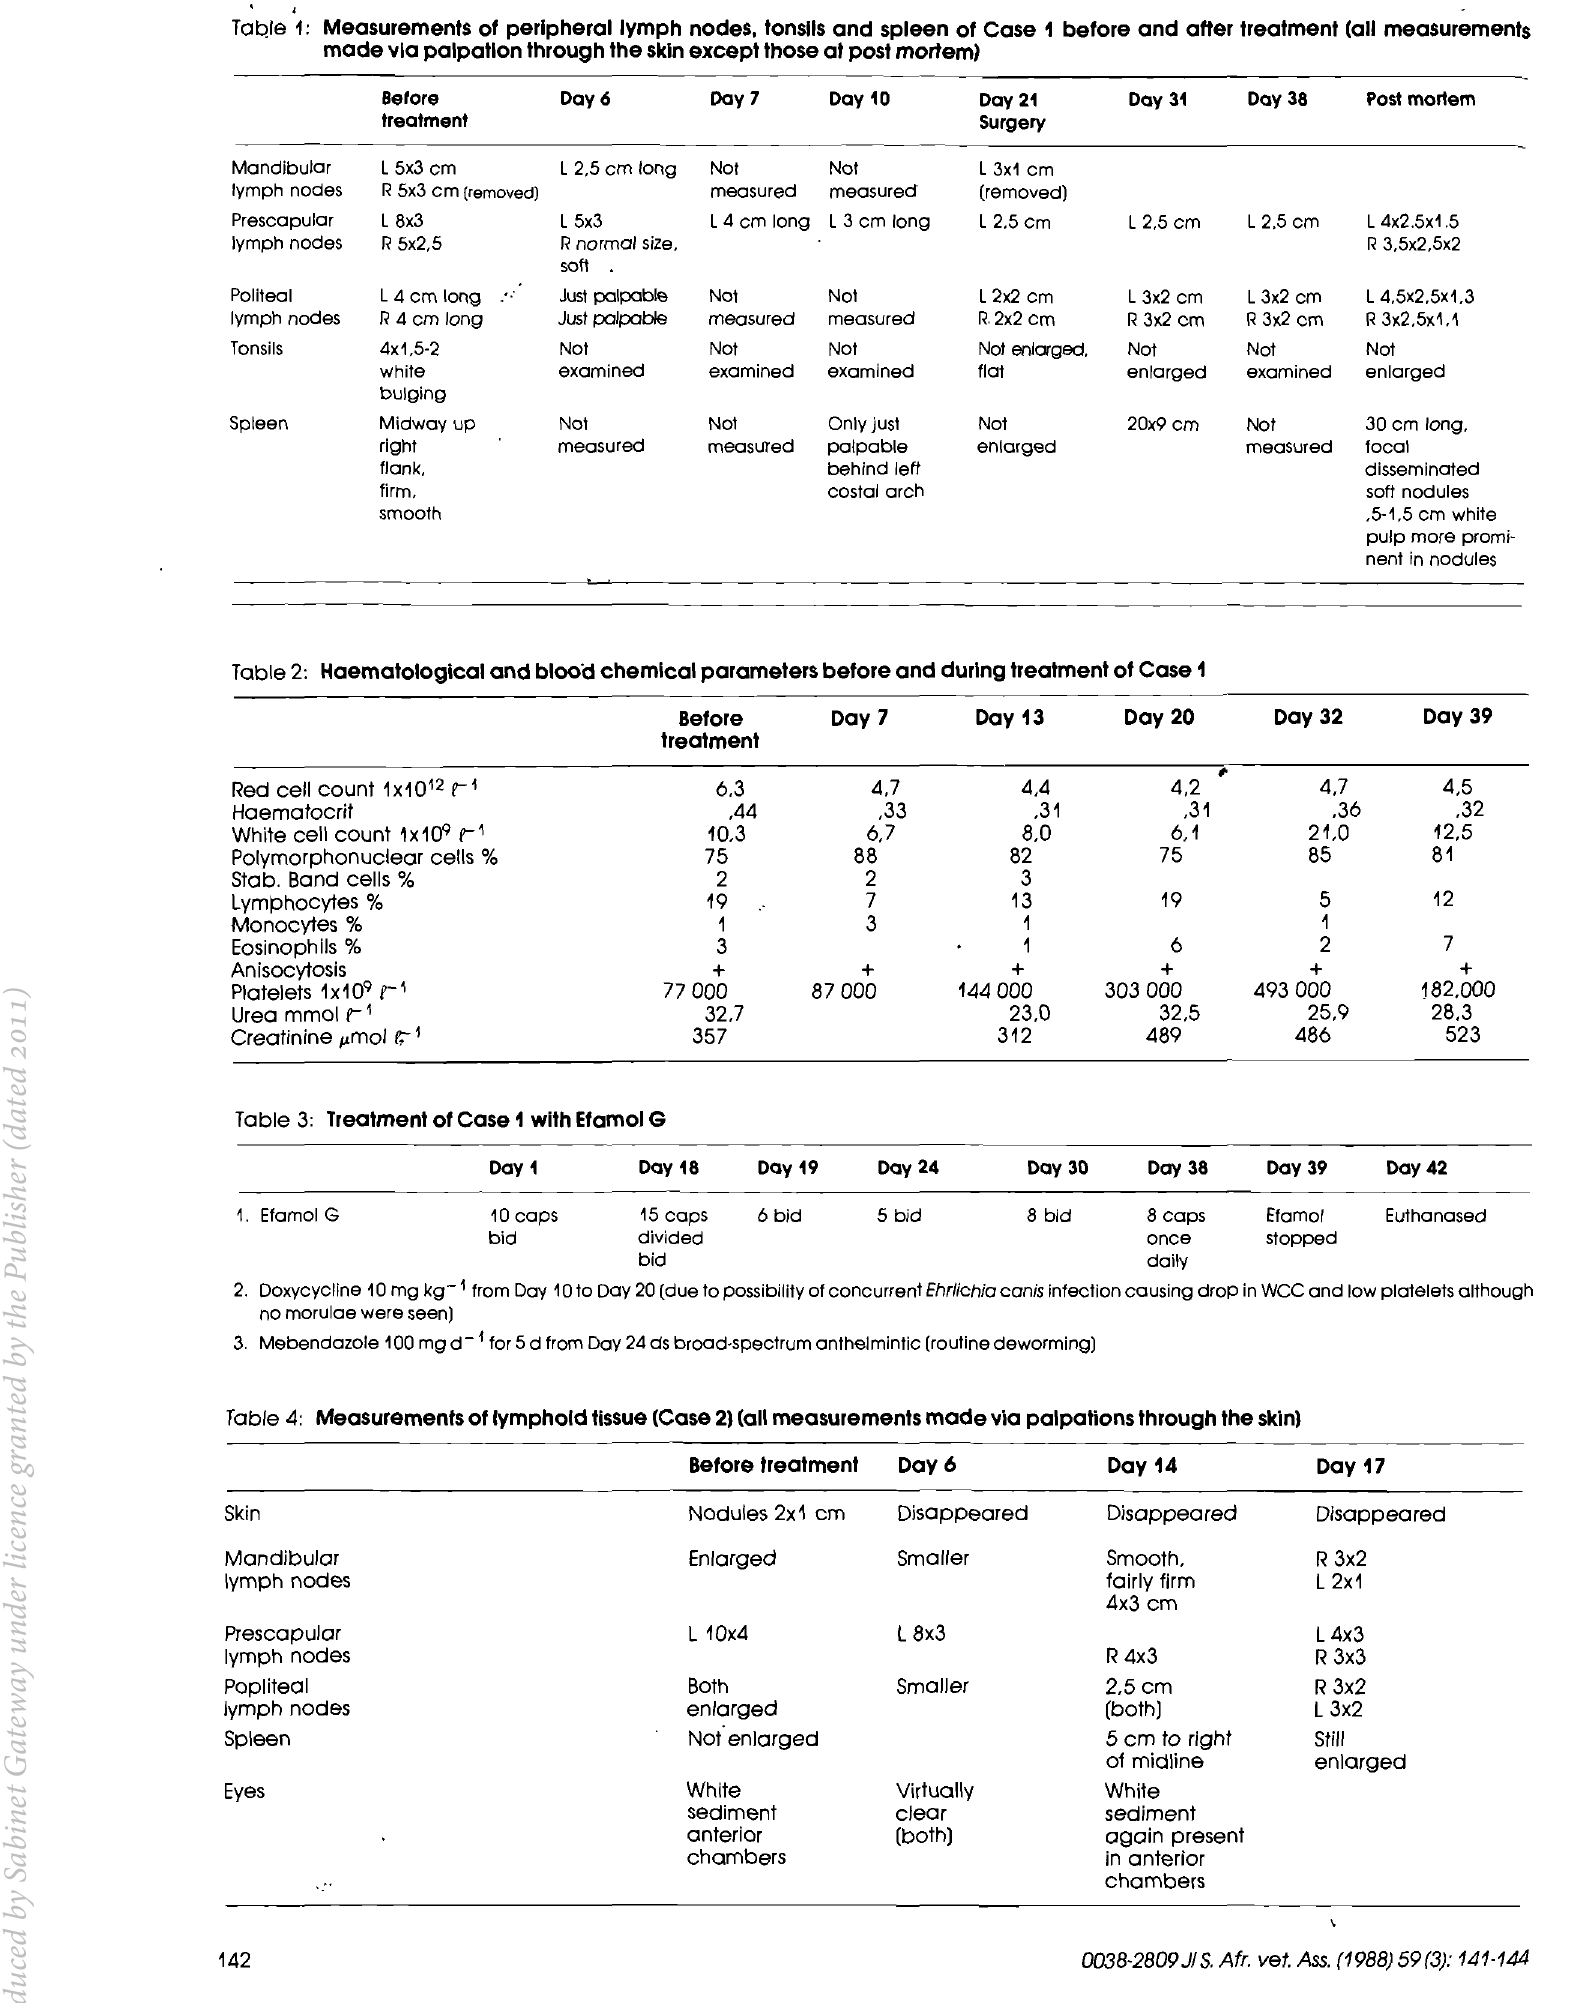
Table 2: Haematological and blood chemical parameters before and during treatment of Case 1 Before